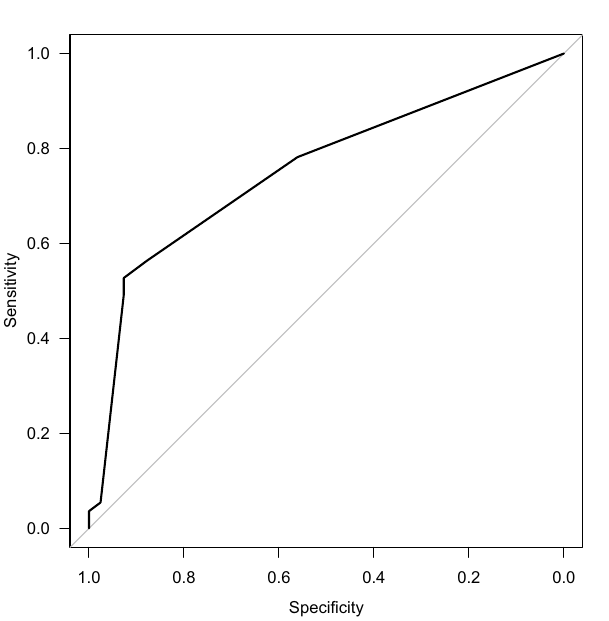
Figure 1. Area under the receiver operator curve of the regression model determining the risk factors for MDR organisms in UTI hospitalised